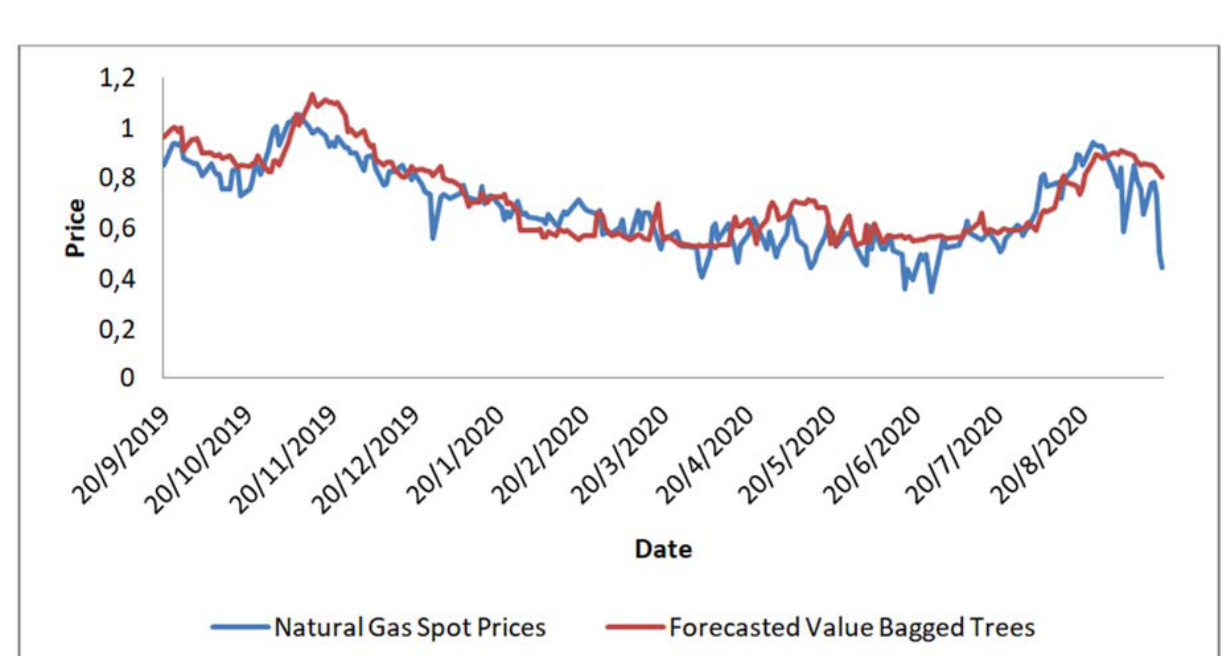
Figure 9. RMSE for t + 5 forecasting.